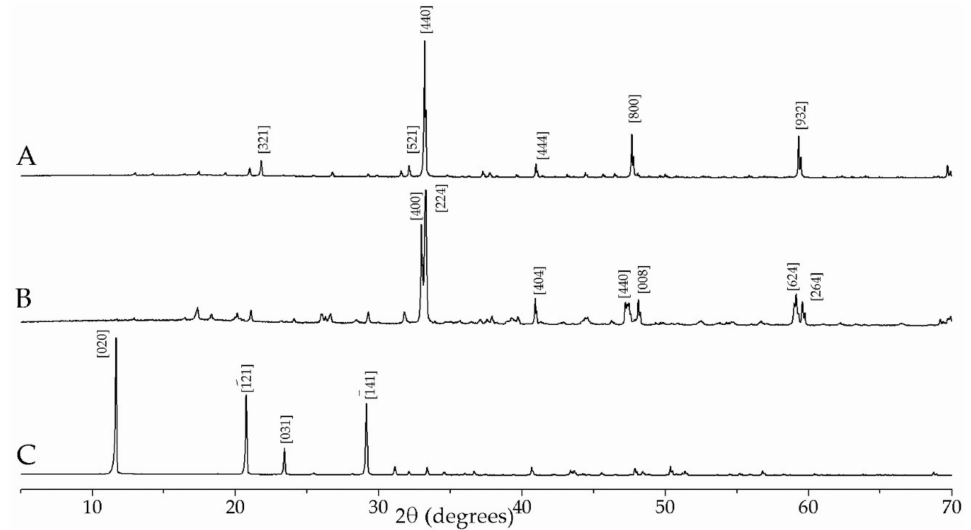
Figure 1. X-ray diffractograms for the un-reacted materials. ( A ) Cub-C 3 A; ( B ) Orth-C 3 A; and ( C )